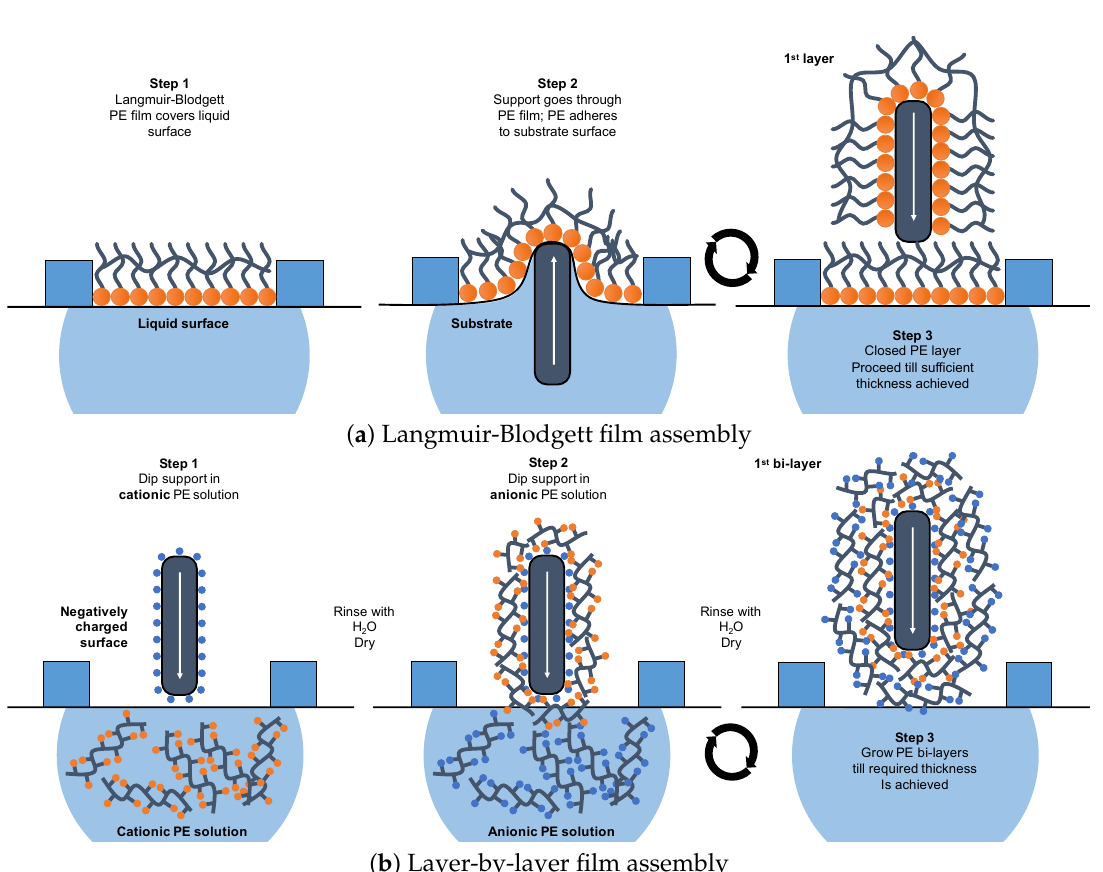
Figure 7. Physical layer deposition of polyelectrolyte films based on ionic